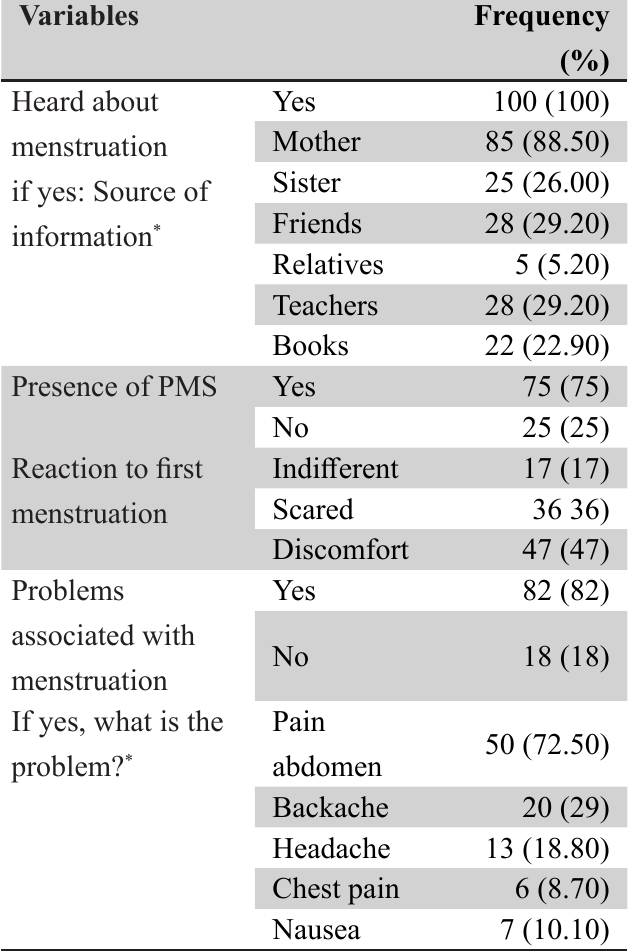
Table 1. Findings Related to Menstrual